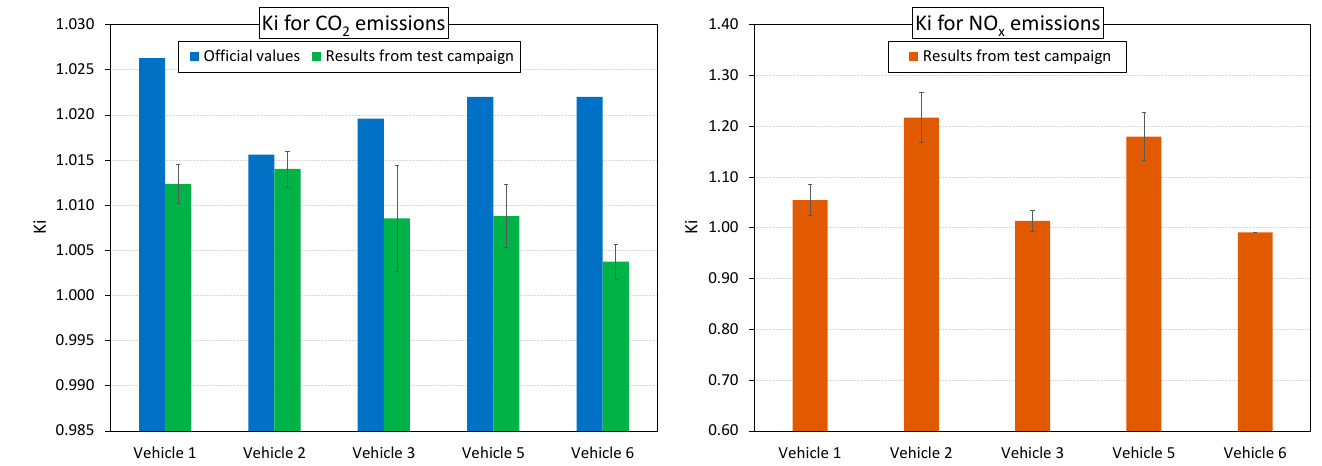
Figure 10. K i factor for CO 2 and NO x emissions, calculated in the test campaign, and comparison with official values (for CO 2 ).